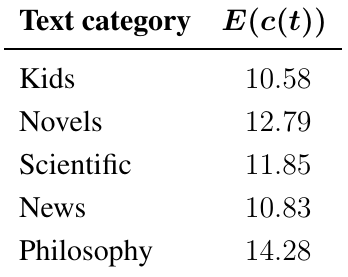
Table 6. Expected frequency classes of analysed